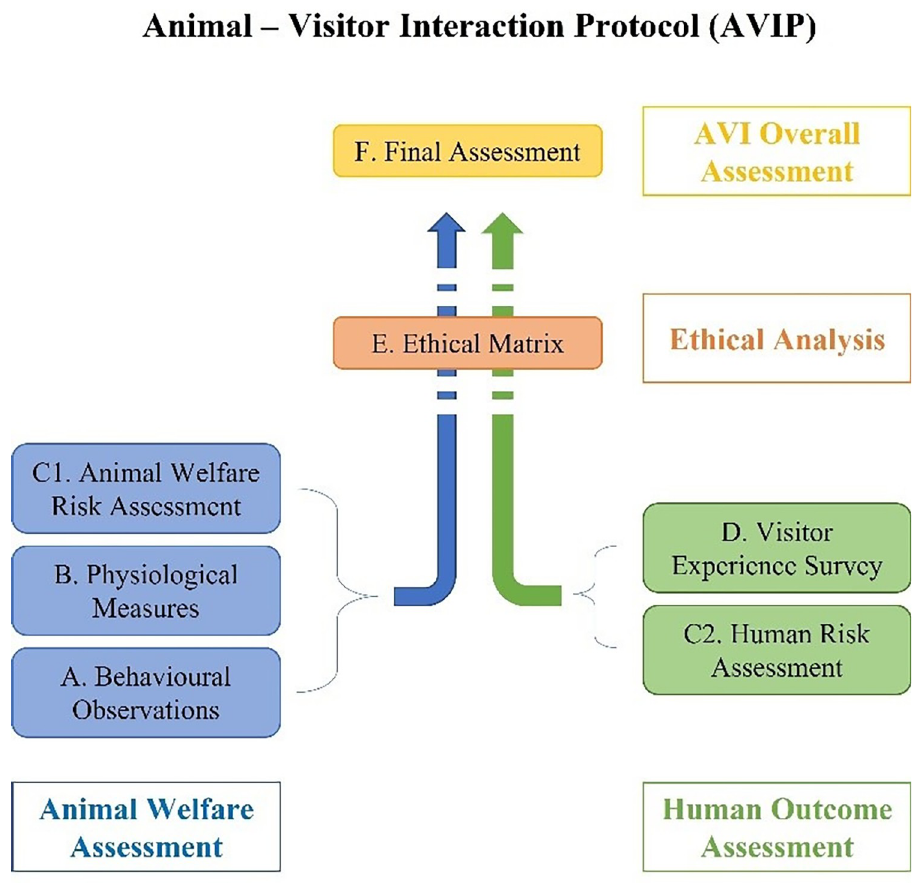
Fig 1. Description of the Animal-Visitor Interaction Protocol (AVIP). The behavioural (step A) and physiological (step B) assessments, together with the Animal Welfare Risk Assessment (step C1), enable to evaluate the effects and consequences of AVIs on animal welfare and health. Steps from C2 to F allow to assess the impact of AVIs on humans involved and to make a final evaluation: Step C2 allows evaluating the impact of AVIs on the safety and welfare of visitors, while step D investigates changes in visitors’ attitudes towards animals and conservation issues, as well as their education and experience in terms of motivation and expectations. The ethical assessment of AVIP (step E) enables to interpret and discuss results obtained by comparing them with an Ethical Matrix, representing the ideal situation for all stakeholders. Finally, through the final checklist (step F), it is possible to provide an explicit result of the evaluation process, by which strengths and weaknesses of an AVI can be identified, managed and communicated. Since both the variation in zoo animal responses to visitors and visitor experience may be the result of species and situation-specific differences, individual animal characteristics, enclosure design, or AVIs nature, the AVIP protocol should be adapted every time to the specific context of the AVI to be evaluated. As a result, AVIP can help to improve management decisions and to ensure a transparent evaluation of AVI